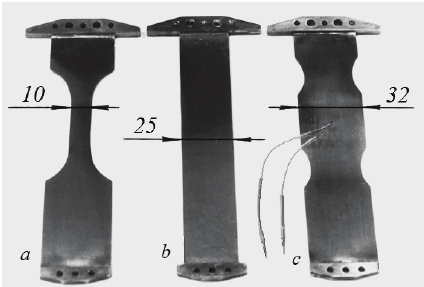
Figure 4. Revolutions counter and current collector: 1 − tachometer light interrupter; 2 − shank of the leading center; 3 and 4 − rotary and stationary contacts of the revolutions counter; 5 − current collector